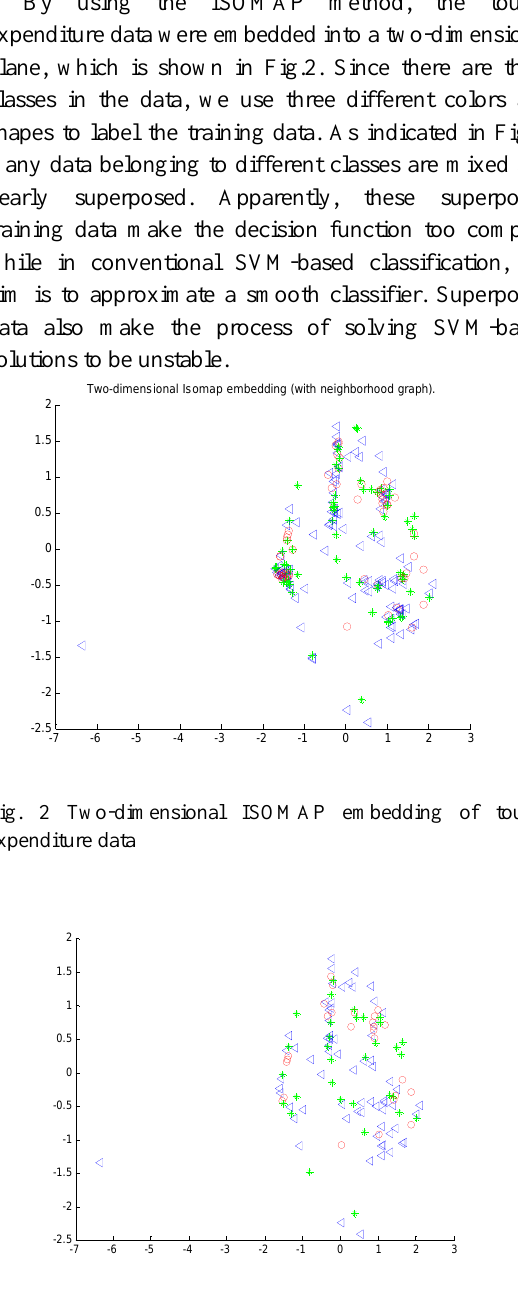
Fig. 3 Two-dimensional ISOMAP embedding of the residual training data after data